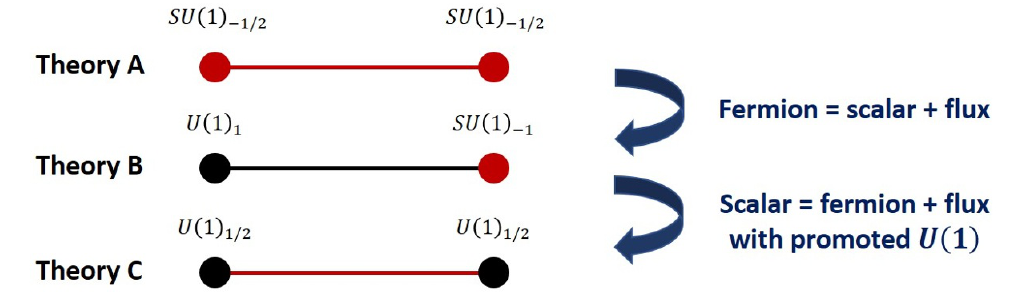
Figure 10 . Fermion particle-vortex duality as a two-node quiver